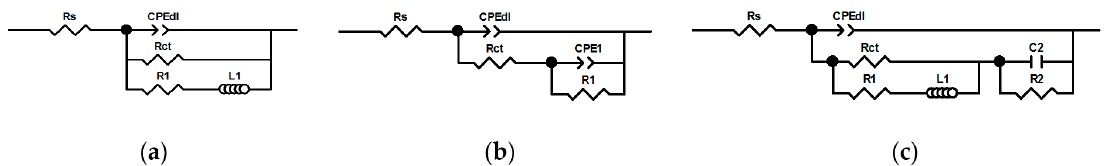
Figure 11. Electrical equivalent circuits used for approximation of the impedance spectra, where R s stands for solution resistance, CPE dl is the constant phase element corresponding to double layer capacitance, R ct is the charge transfer resistance, other EECs’ elements are related adsorption and precipitation of insoluble film: ( a ) case of selective corrosion, when c V = 0 mM, pH = 1.3, t ≥ 437 min, c V = 0 mM, pH = 2.5; ( b ) case of corrosion inhibition, when when c V = 100 and 200 mM, pH = 1.3, c V = 200 mM, pH = 2.5, t = 159 min; ( c ) case of selective corrosion, when c V = 0 mM, pH = 1.3, t < 437 min, c V = 10 and 50 mM.